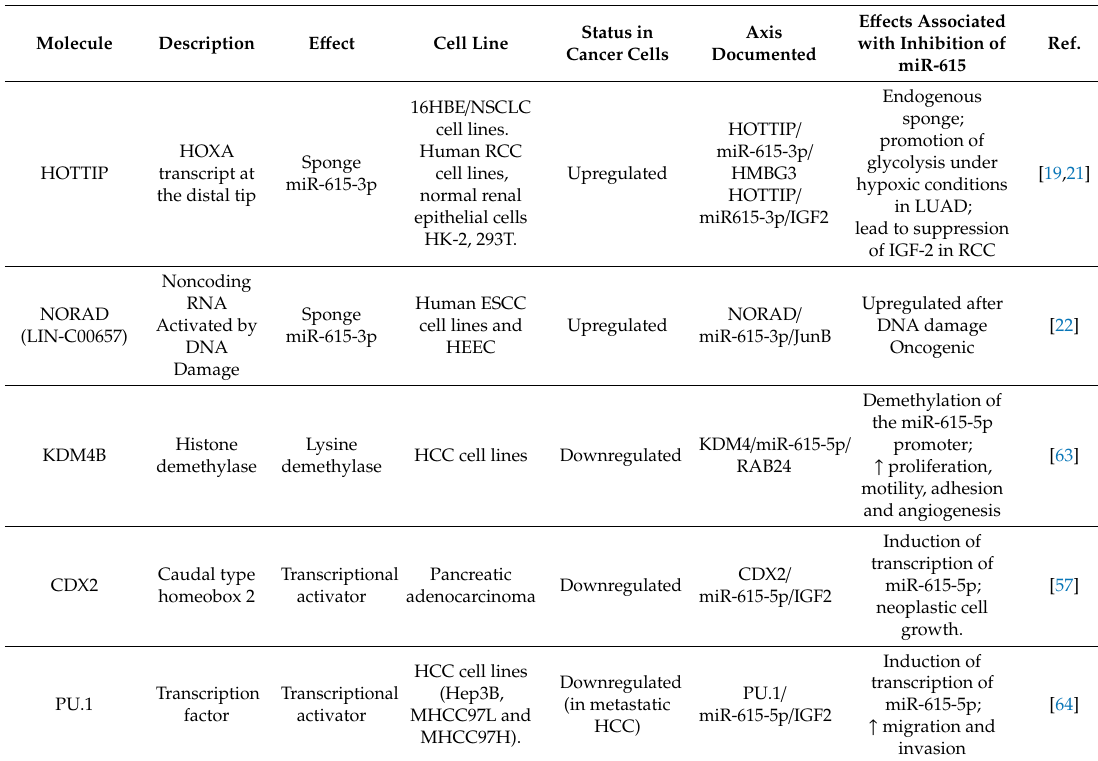
FIGO, International Federation of Gynecology and Obstetrics; HCC, hepatocellular carcinoma; LUAD, lung adenocarcinoma; NF- κ B, nuclear factor kappa B; NSLCC, non-small cell lung carcinoma; RCC, renal cell carcinoma; TNM, tumor nodes